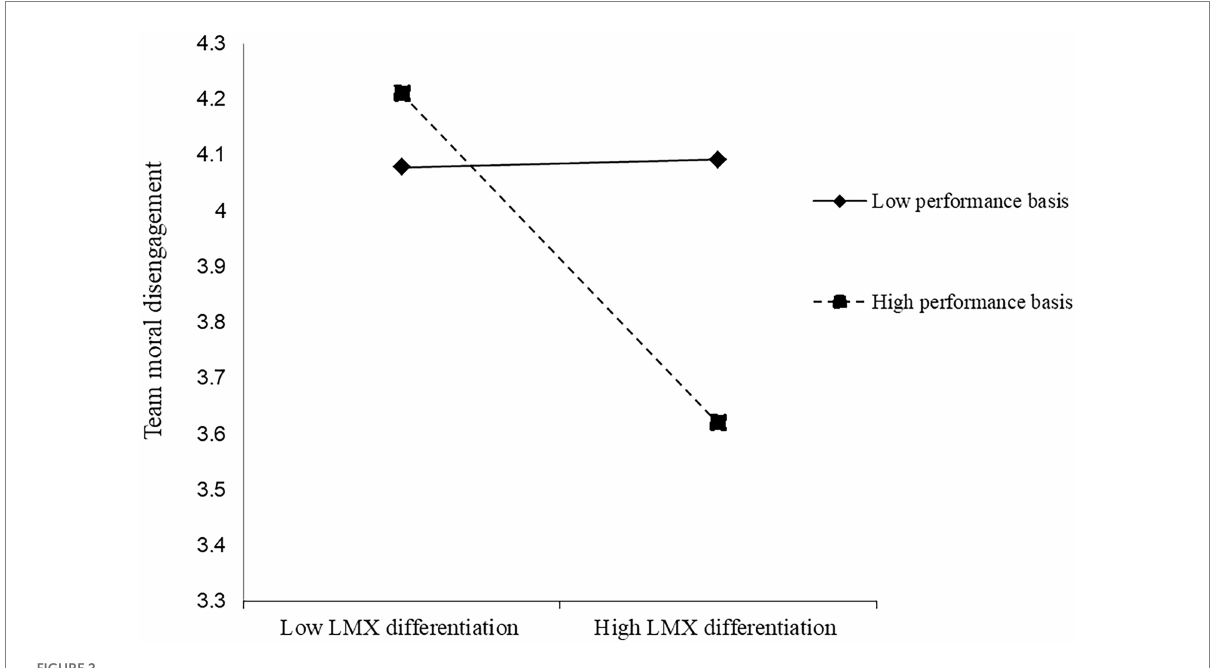
FIGURE 2 Interaction between LMX differentiation and performance basic.